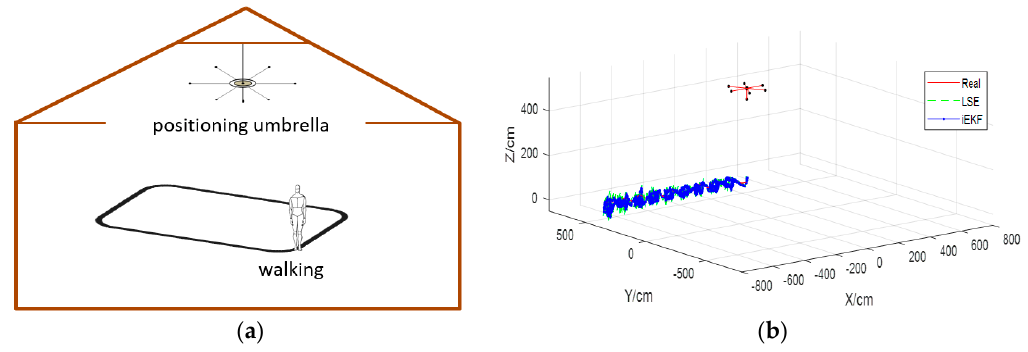
Figure 4. Left foot trajectory in walking model. ( a ) Walking model. ( b ) Trajectory of left foot.